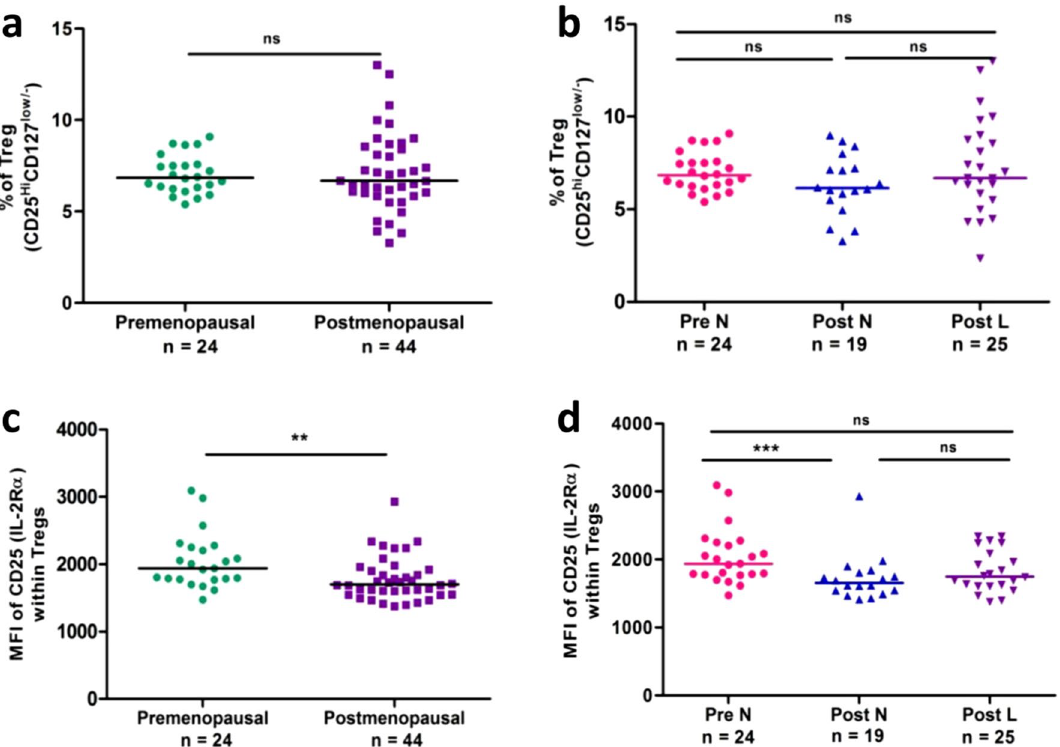
Figure 1. Frequencies of Treg cells and per-cell expression of CD25 on Treg cells in premenopausal women (n = 24) and postmenopausal women (n = 44) group ( a & c ) and in 3 cohorts ( b & d ): Pre-N (n = 24), Post-N (n = 19) and Post-L (n = 25). Data are expressed as scatter plots. Pairwise comparison (left panel) was done using the Mann–Whitney U test and multiple group comparison was done using the Kruskal–Wallis test